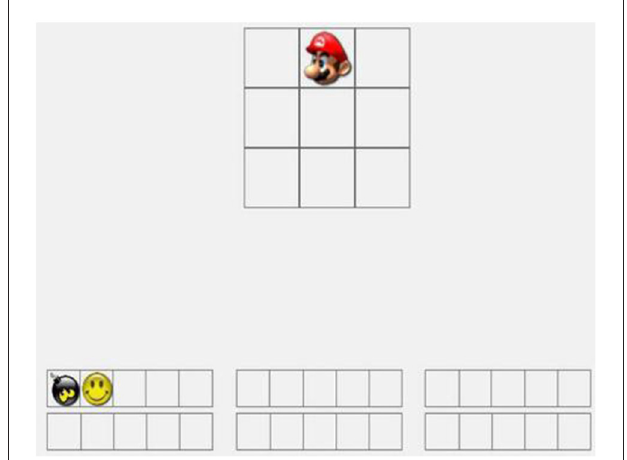
FIGURE 2 | Demonstration of animals running WM